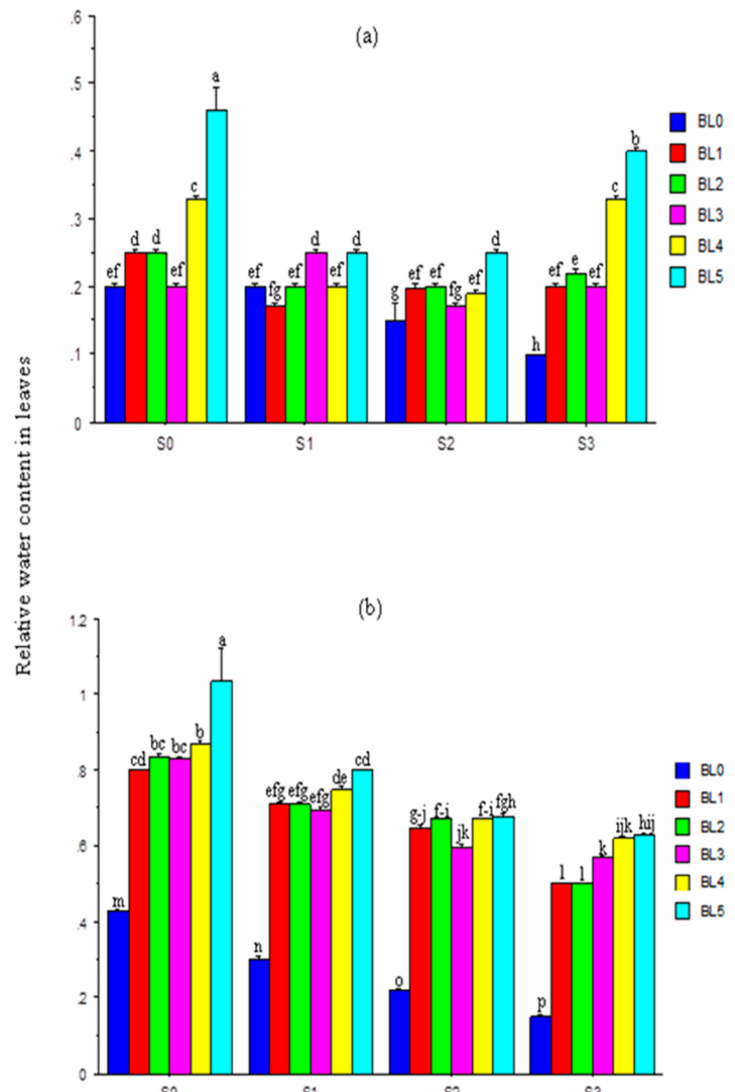
Figure 2. Interaction effects of salinity × brassinolide on relative water content in leaves of soybean at 20 ( a ) and 30 ( b ) DAS. BL—brassinolide; S—salinity; DAS—days after sowing; BL0—no BL application (control); BL1—BL application at seedling; BL2—BL application at flowering; BL3— BL application at podding; BL4—BL application at seedling + flowering; BL5—BL application at seedling + flowering + podding; S0—1.10 mM/L (control); S1—32.40 mM/L; S2—60.60 mM/L; S3—86.30 mM/L. Mean pairs with different letters are significantly different at the 5% probability level according to Duncan’s new multiple-range